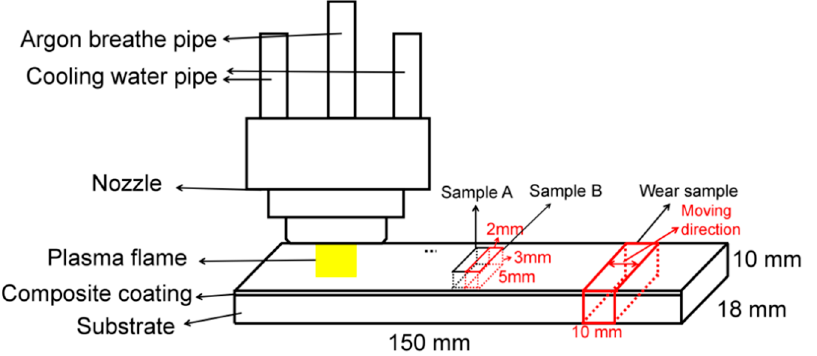
Figure 1. The diagram of plasma cladding treatment.